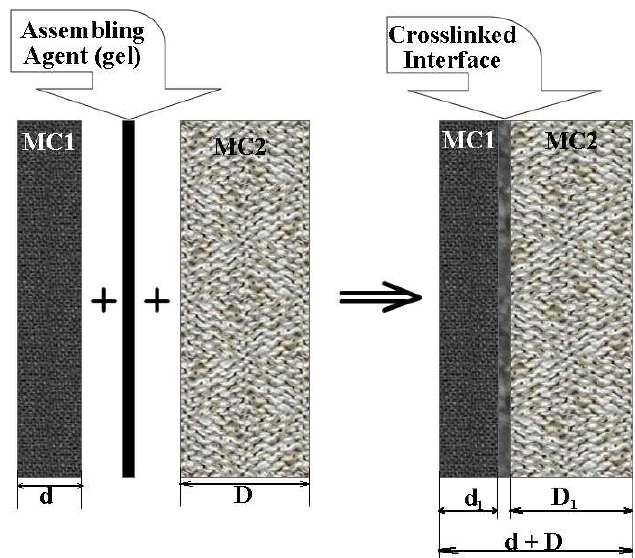
Figure 1. Schematic presentation of the assembly process of two composite layers, with different ceramic